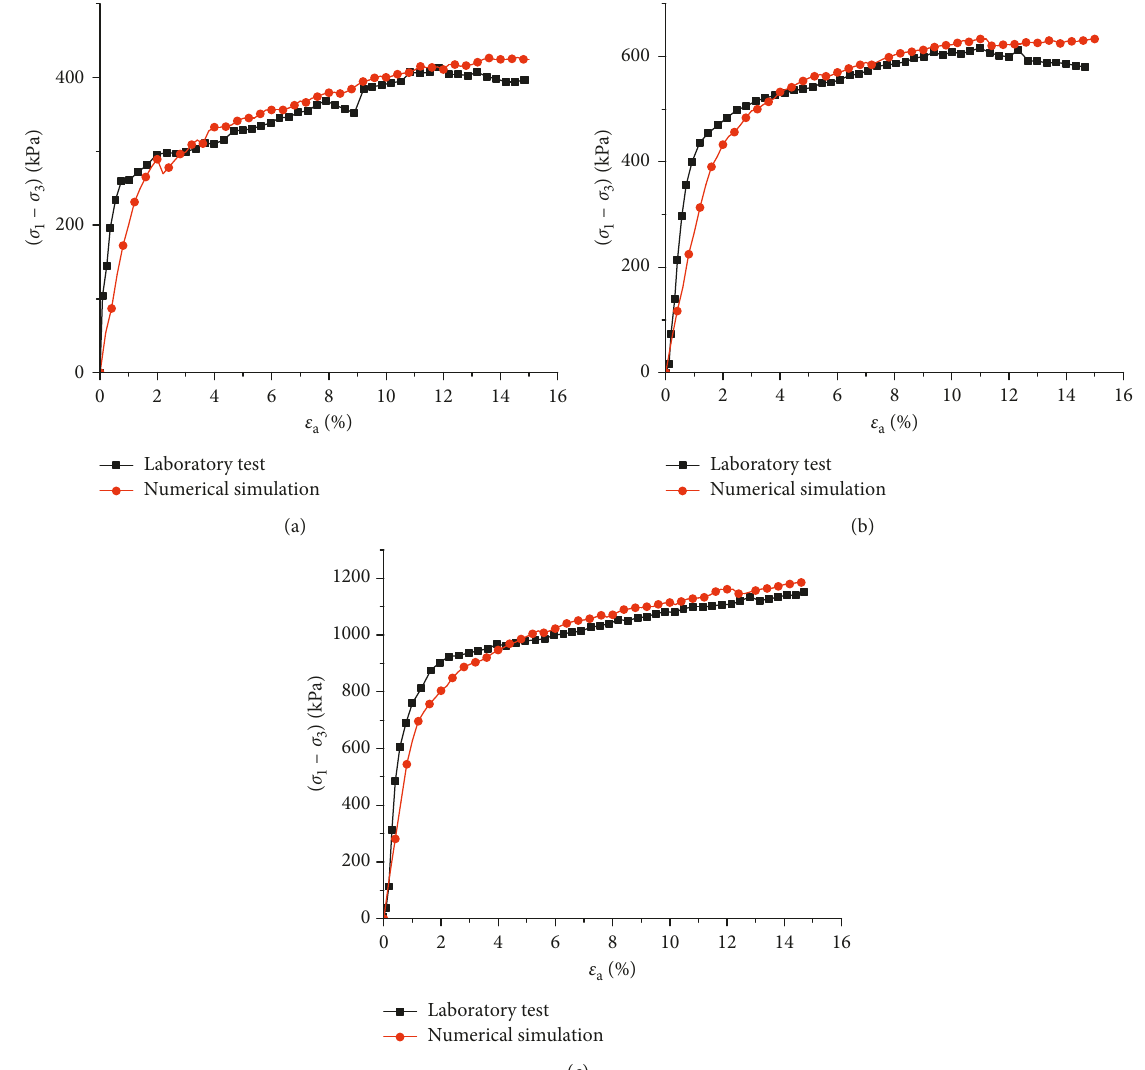
Figure 5: Variation laws of stress-strain curves under different confining pressures: (a) 200kPa; (b) 400kPa; (c)